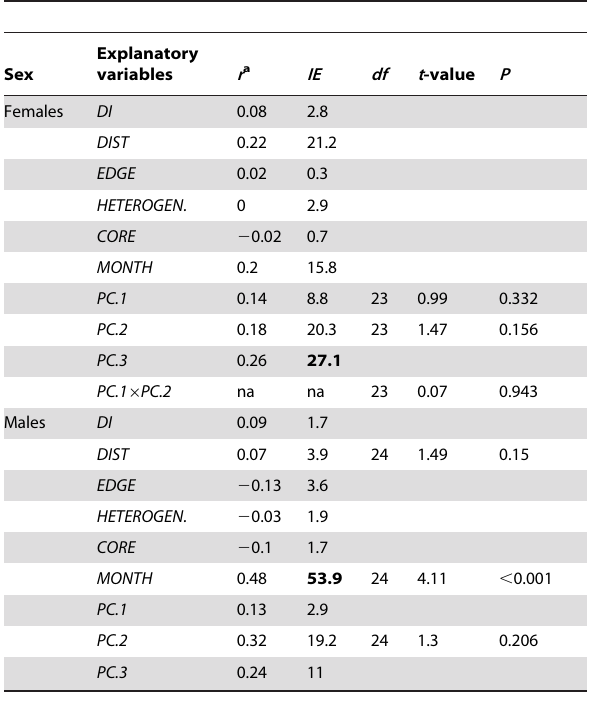
a Pearson’s correlation coefficients ( r ), the independent effect of variables from hierarchical partitioning ( IE ), and results of linear mixed effect model fitting are shown. Degrees of freedom, t -value and P -values are shown for variables that were selected for inclusion in the reduced LMEM using Akaike Information Criterion.